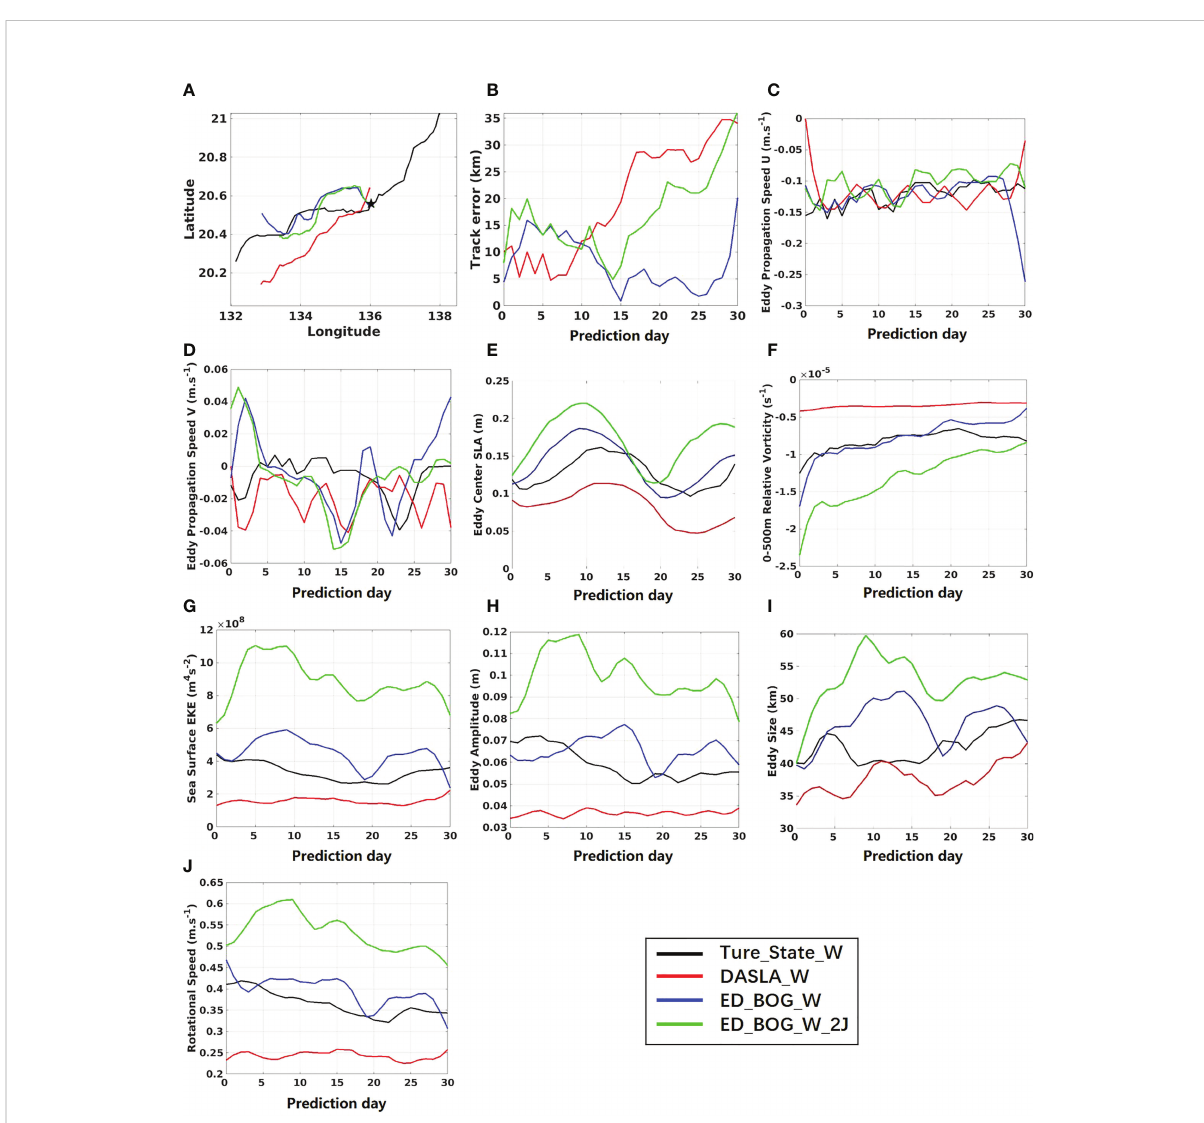
FIGURE 8 The (A) track, time series of (B) track prediction error, (C) mu, (D) mv, (E) strength, (F) RV, (G) SSEKE, (H) amplitude, (I) scale and (J) ROS of predicted eddy from “ true ” warm eddy, DASLA_W, ED_BOG_W and ED_BOG_2J during the prediction